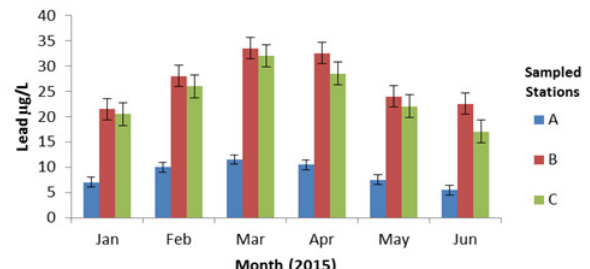
Fig. 14. The monthly mean variation in the lead (mg/L) levels of the water sampled from Saba River